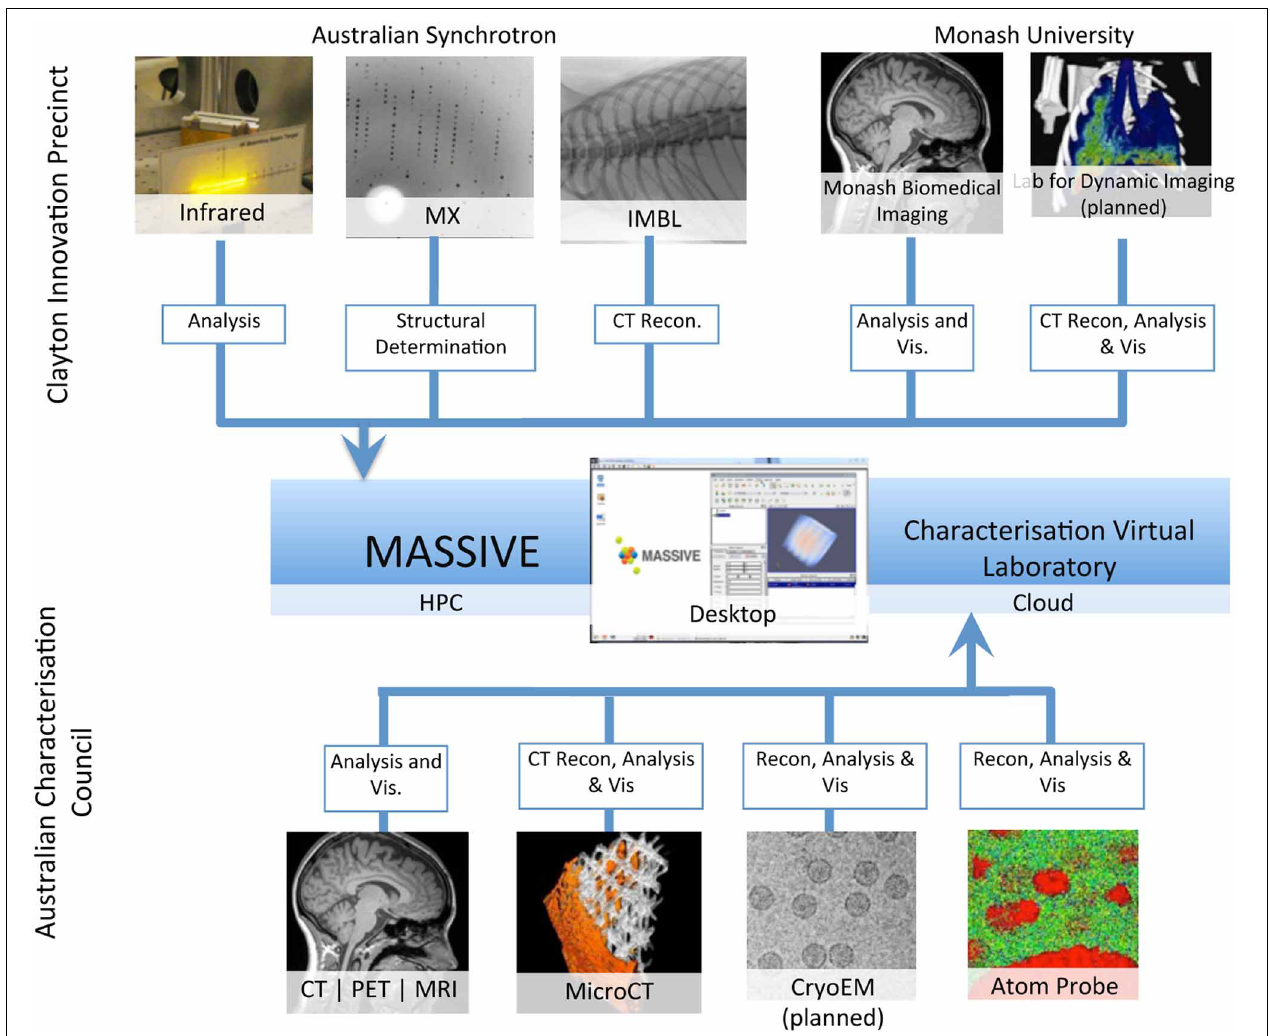
FIGURE 2 | A schematic of the integration of access to imaging instrumentation from the MASSIVE desktop and the Cloud via the Characterization virtual